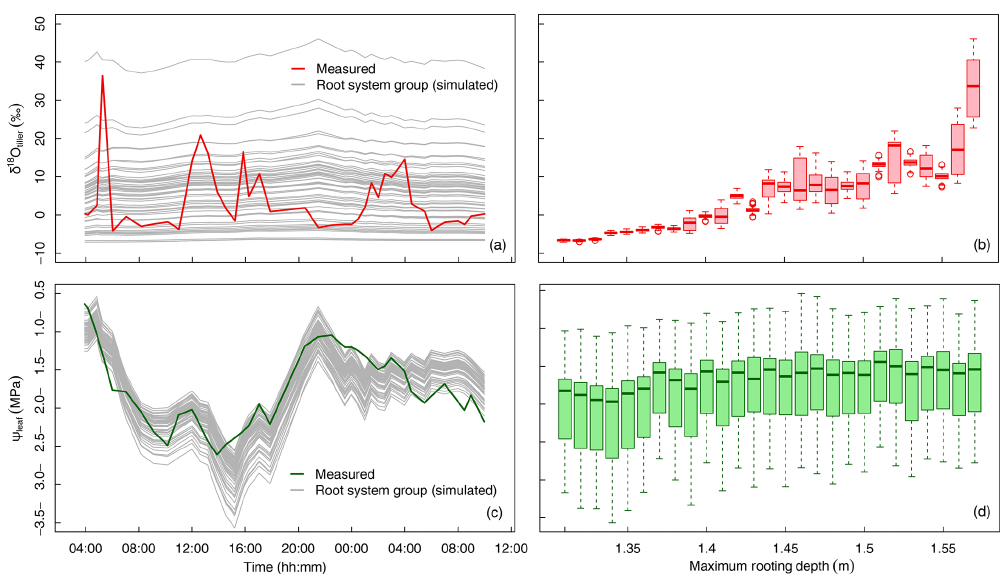
Figure 5. Variation in δ tiller and ψ leaf in time and across the 60 groups of simulated root systems. (a) The measured (thick red line) and simulated (thin gray lines, one line per root system group, following a “swarm” pattern) temporal dynamics of δ tiller . (b) Boxplot of simulated δ tiller values for each root system maximum depth, in 1cm increments. (c) The measured (thick green line) and simulated (thin gray lines, one line per root system group, following a “roller-coaster” pattern) temporal dynamics of ψ leaf . (d) Boxplot of simulated ψ leaf values for each root system maximum depth, in 1cm increments. Table 1. Optimum and limits of the four-dimensional parametric space explored by the global optimization algorithm aiming at minimizing the difference between simulated and observed δ tiller and ψ leaf , as well as their standard deviation from average values during the full